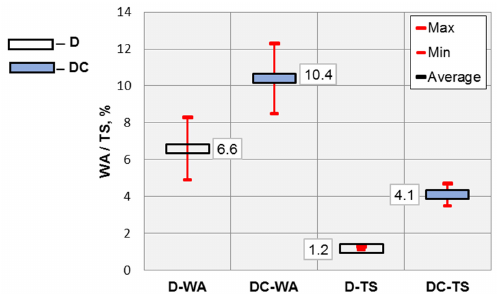
Figure 8. Water absorption (WA) and thickness swelling (TS) after 24 h of immersion of D and DC composites into